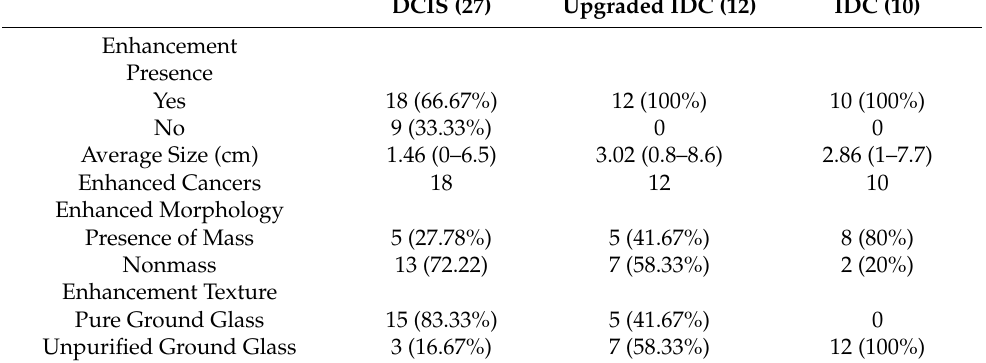
Table 3. Comparison of CESM enhanced features of pure DCIS, upgraded IDC and IDC.